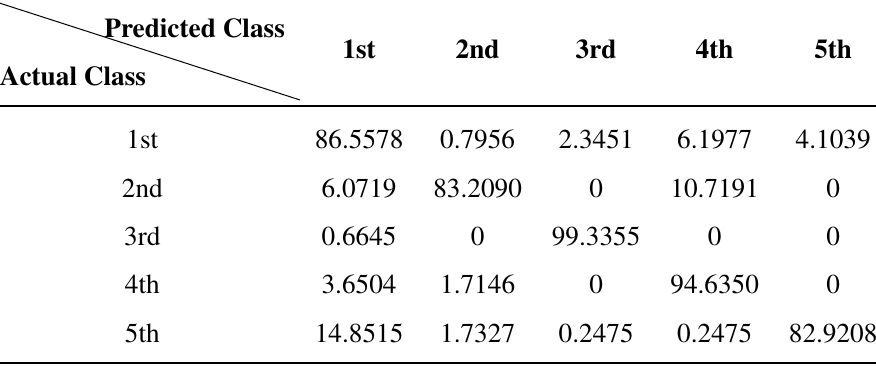
Table 7. Confusion matrix for RBFNN with 11 hidden neurons, mean shift-filtered patches, 500 × 500-pixel patches and parameter Set IV (values in %).